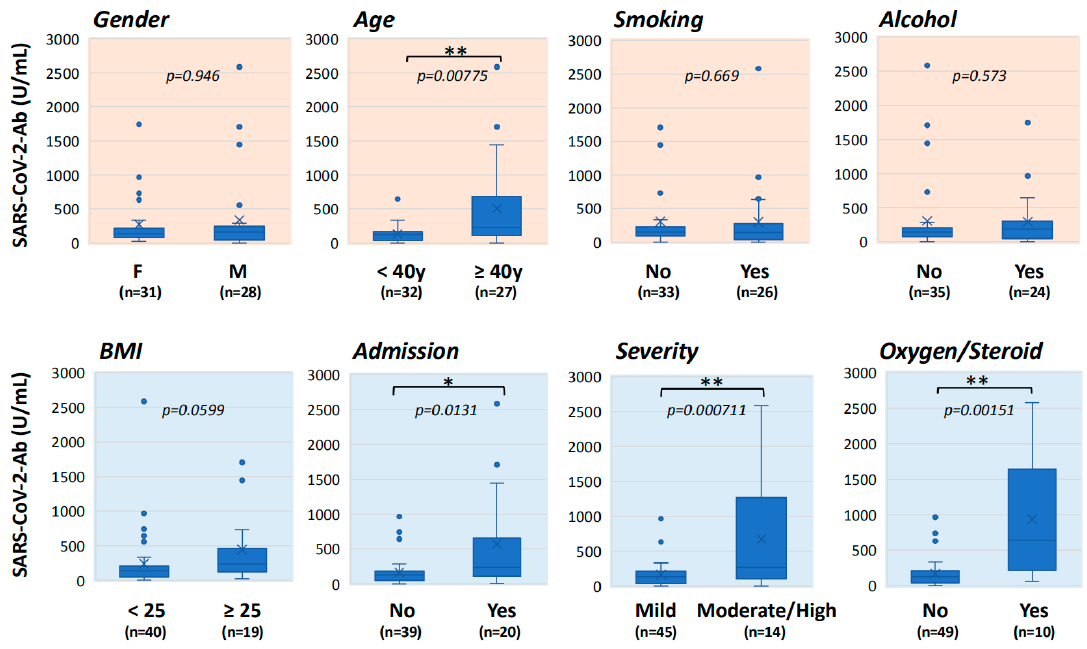
Figure 5. Differences of serum antibody titers based on the clinical background. Serum anti-SARS- CoV-2 antibody levels of the long COVID patients at the initial visit were compared between two groups based on the patients’ backgrounds and clinical factors related to COVID-19. In each panel, the upper horizontal line of the box is the 75th percentile, the lower horizontal line of the box is the 25th percentile, the horizontal bar within the box is the median, the upper horizontal bar outside the box is the maximum value within 1.5 times of the interquartile range, and the lower horizontal bar outside the box is the minimum value within 1.5 times of the interquartile range. The data were analyzed by the Mann-Whitney U test: ** p < 0.01 and * p < 0.05, statistically significant between the indicated factors (“ n ” indicates the number of patients).